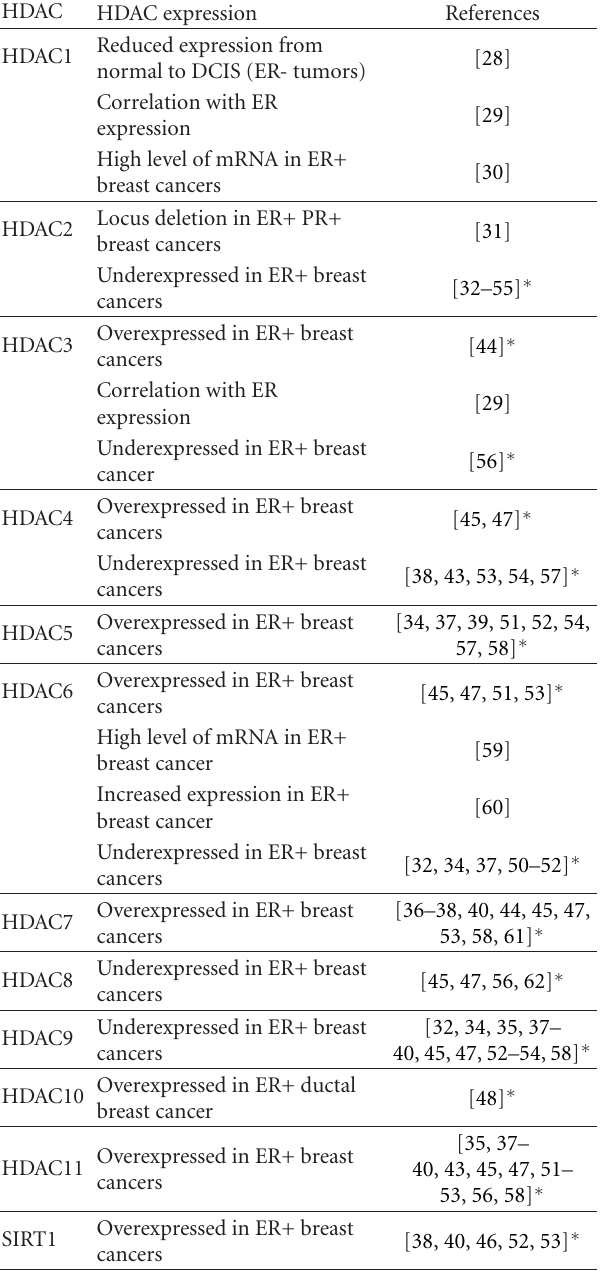
Table 1: Expression of HDACs in relation with